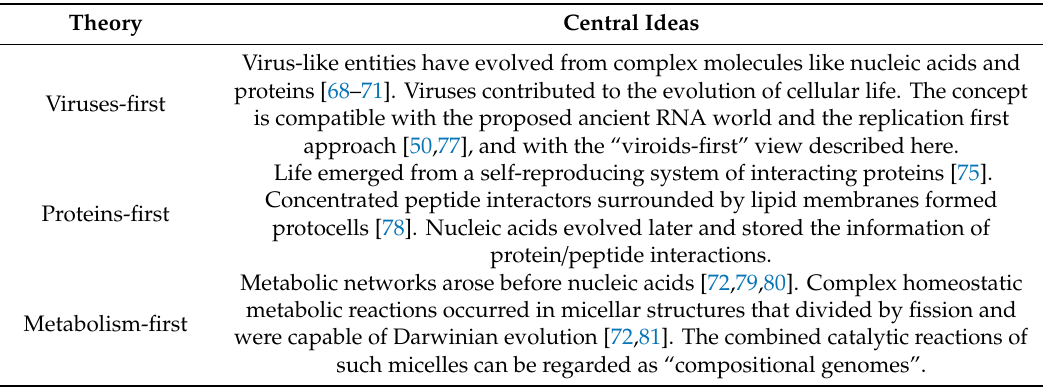
Table 1. Non-exhaustive list of theories on the origin of life on Earth.